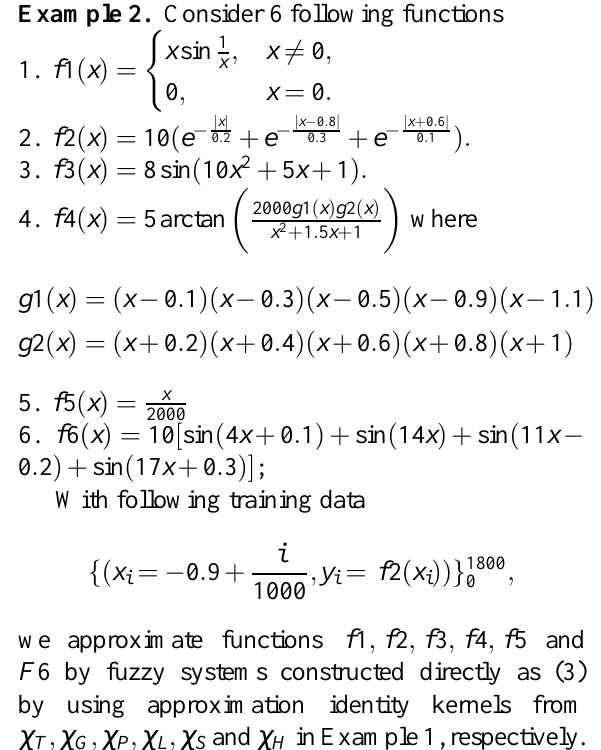
Fig. 6. Trapezoidal set function.